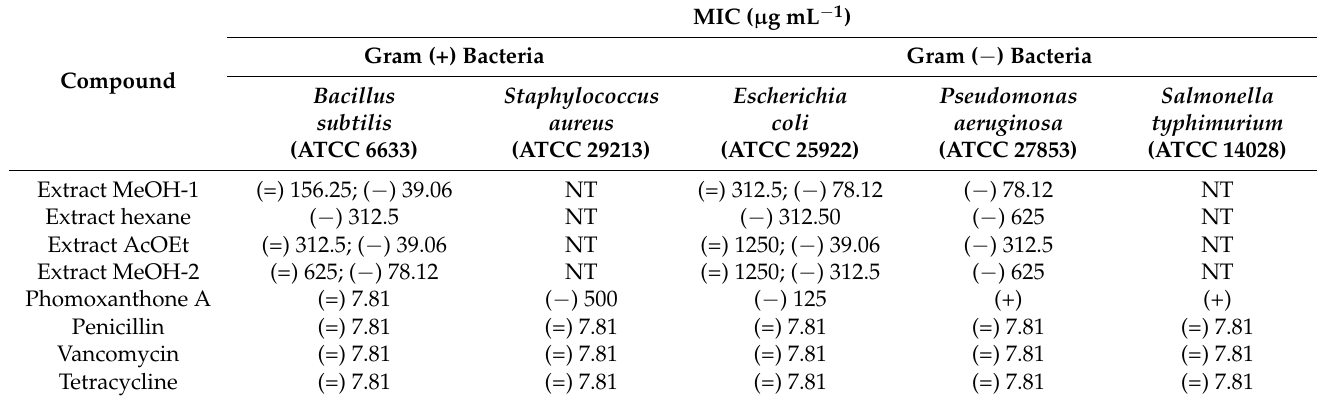
Table 1. Antimicrobial activity of extracts and compounds isolated from Paecilomyces sp. EJC01.1.